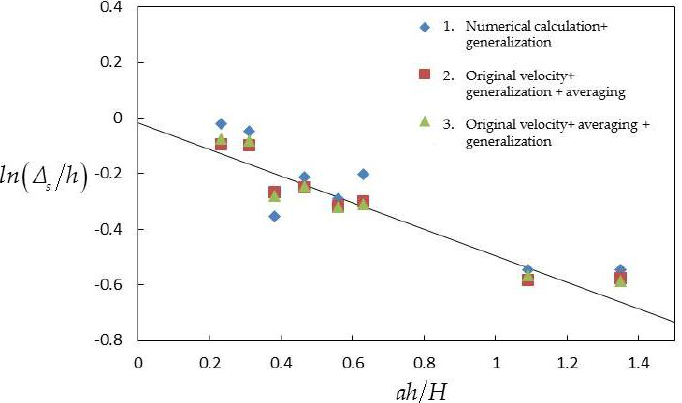
Figure 13. Height of the theoretical zero point Δ s varies with the comprehensive parameter ah/H (3 cases).